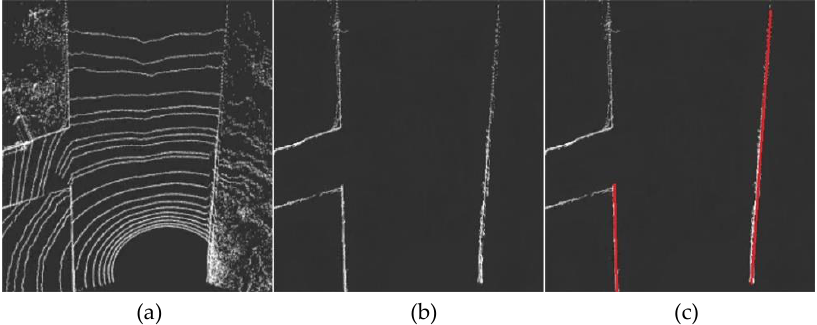
Figure 14. Curb detection of a typical T-shaped intersection scene. ( a ) is the extracted foreground point clouds of T-shaped intersection. ( b ) is the boundary result extracted by the algorithm. ( c ) is the boundary fitting result.